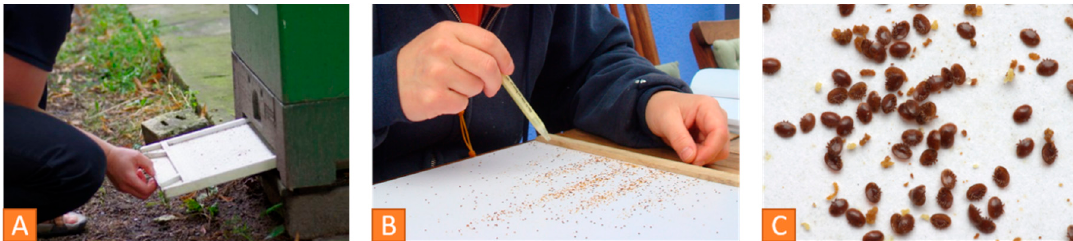
Figure 8. Varroa infestation control via debris examination: ( A ) A drawer with a sticky paper is put under the hive, ( B ) counting the number of Varroa mites, ( C ) close-up of Varroa mites on the drawer. © Jens Emmerich.